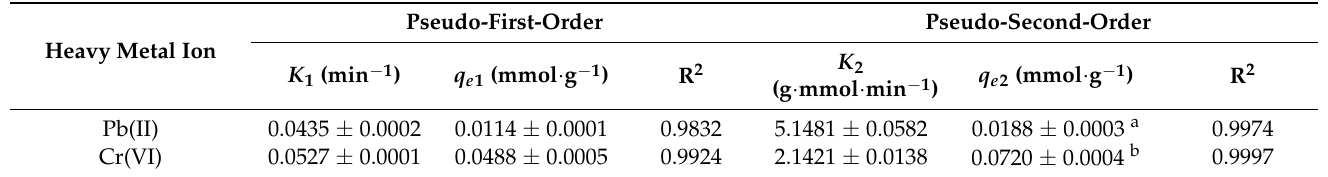
Table 5. The kinetic adsorption parameters were obtained using pseudo-first-order and pseudo- second-order for the adsorption of Cr(VI) and Pb(II).